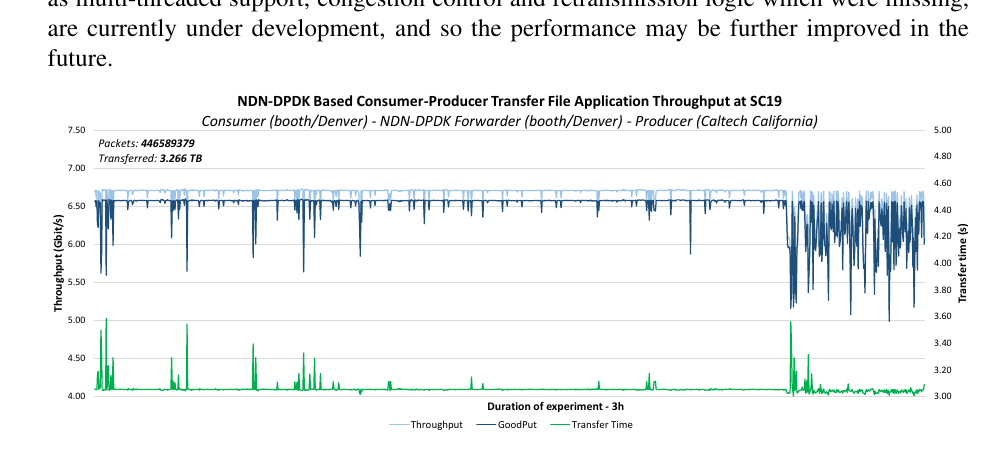
Figure 4: SC 19 Demo: Real-time Performance